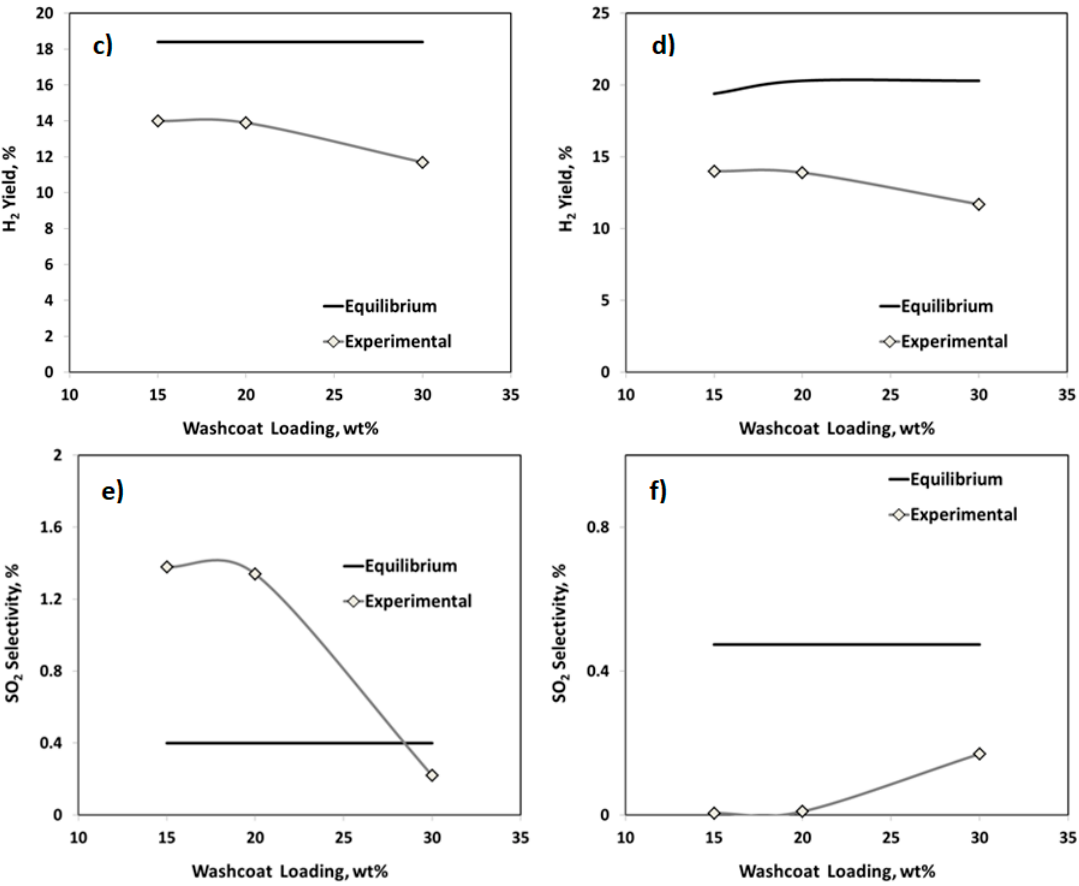
Figure 3. Effect of the washcoat loading at T = 1000 °C ( left ), T = 1100 °C ( right ), in terms of H 2 S conversion ( a , b ), H 2 Yield ( c , d ), SO 2 selectivity ( e , f